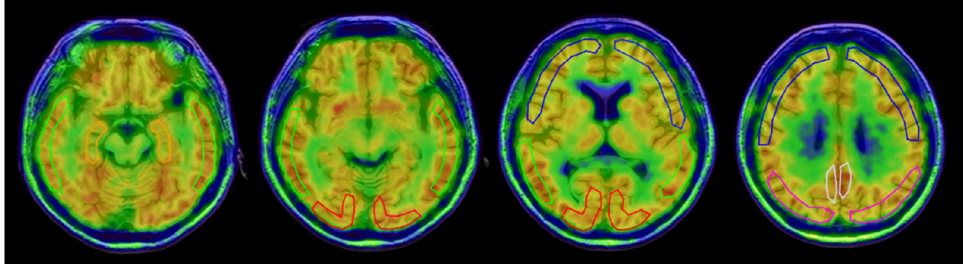
Figure 2. An example of ROIs for frontal (blue), temporal (green), parietal (magenta), and occipital (red) lobes, hippocampus (orange) and posterior cingulate cortex (gray) drawn in a single subject.